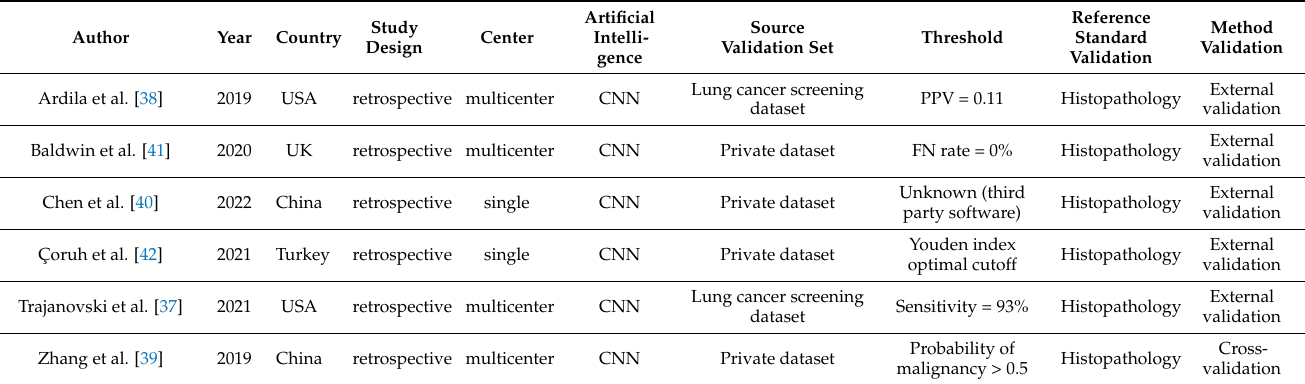
Table 1. Characteristics of the included studies.